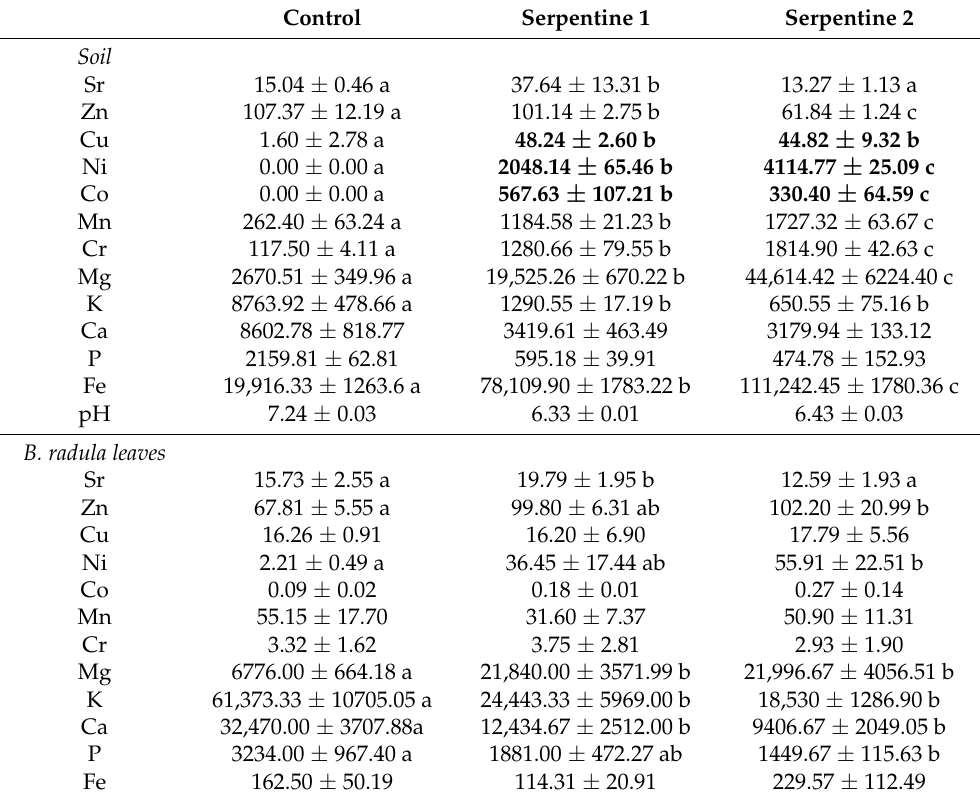
Table A1. Trace metals and macronutrient concentrations (Mean ± Std) in soil and B. radula leaves under the study treatments. Values in bold are above permissible limits [38]. Different letters in the same line indicate significant differences among